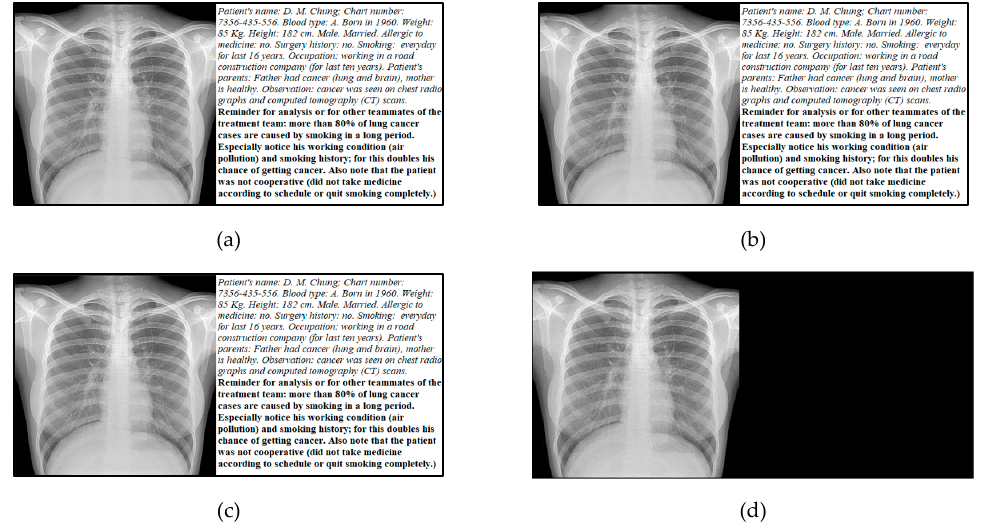
Figure 4. An application example of the sharing with forbidden combination. ( a ) The original 512 × 1024 lung x -ray image of a patient. ( b – c ) Any 2 of the 4 shadows can be used together to recover ( a ) without errors. Here, ( b ) is obtained by doctors { D 1 , D 3 }; whereas ( c ) is by doctors { D 2 , D 4 }. However, if the two shadows are from the forbidden combination { D 1 , D 2 }, then the recovery is (d), i.e., without the medical history of the patient.